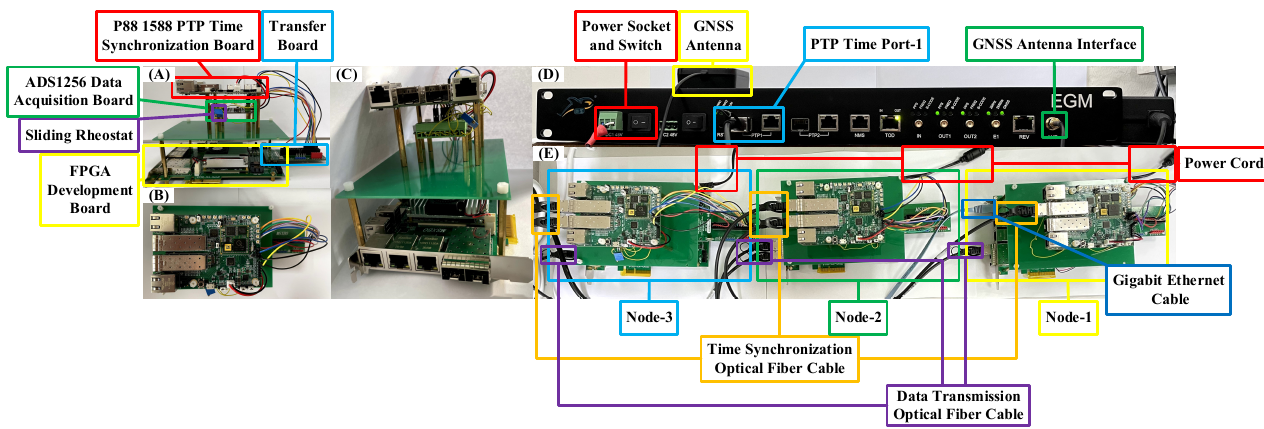
Figure 5. ( A ) Node main view and its components; ( B ) Node top view; ( C ) Node side view; ( D ) EGM master clock photo and interface description; ( E ) Transmission link photo and wiring relationship between nodes.